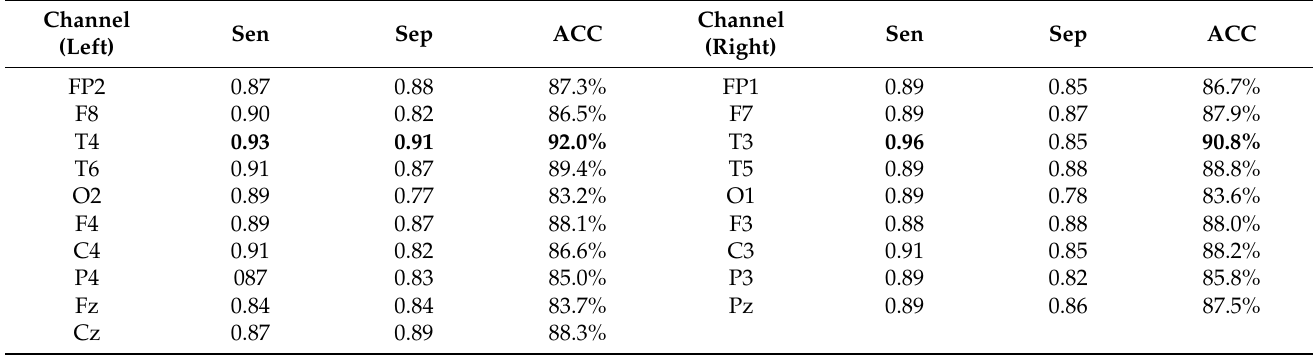
Table 3. The classification results based on leave-one-out cross-validation using a single channel per time for the eyes-closed